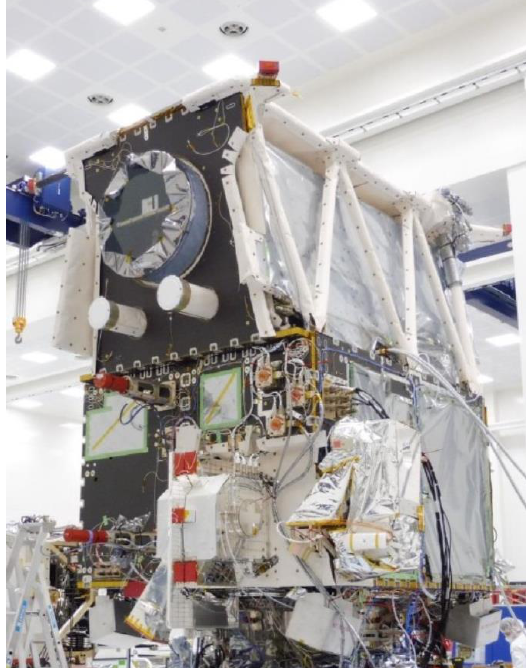
Figure 15. ATLID integrated on EarthCARE satellite platform. Reproduced with permission of Airbus © .